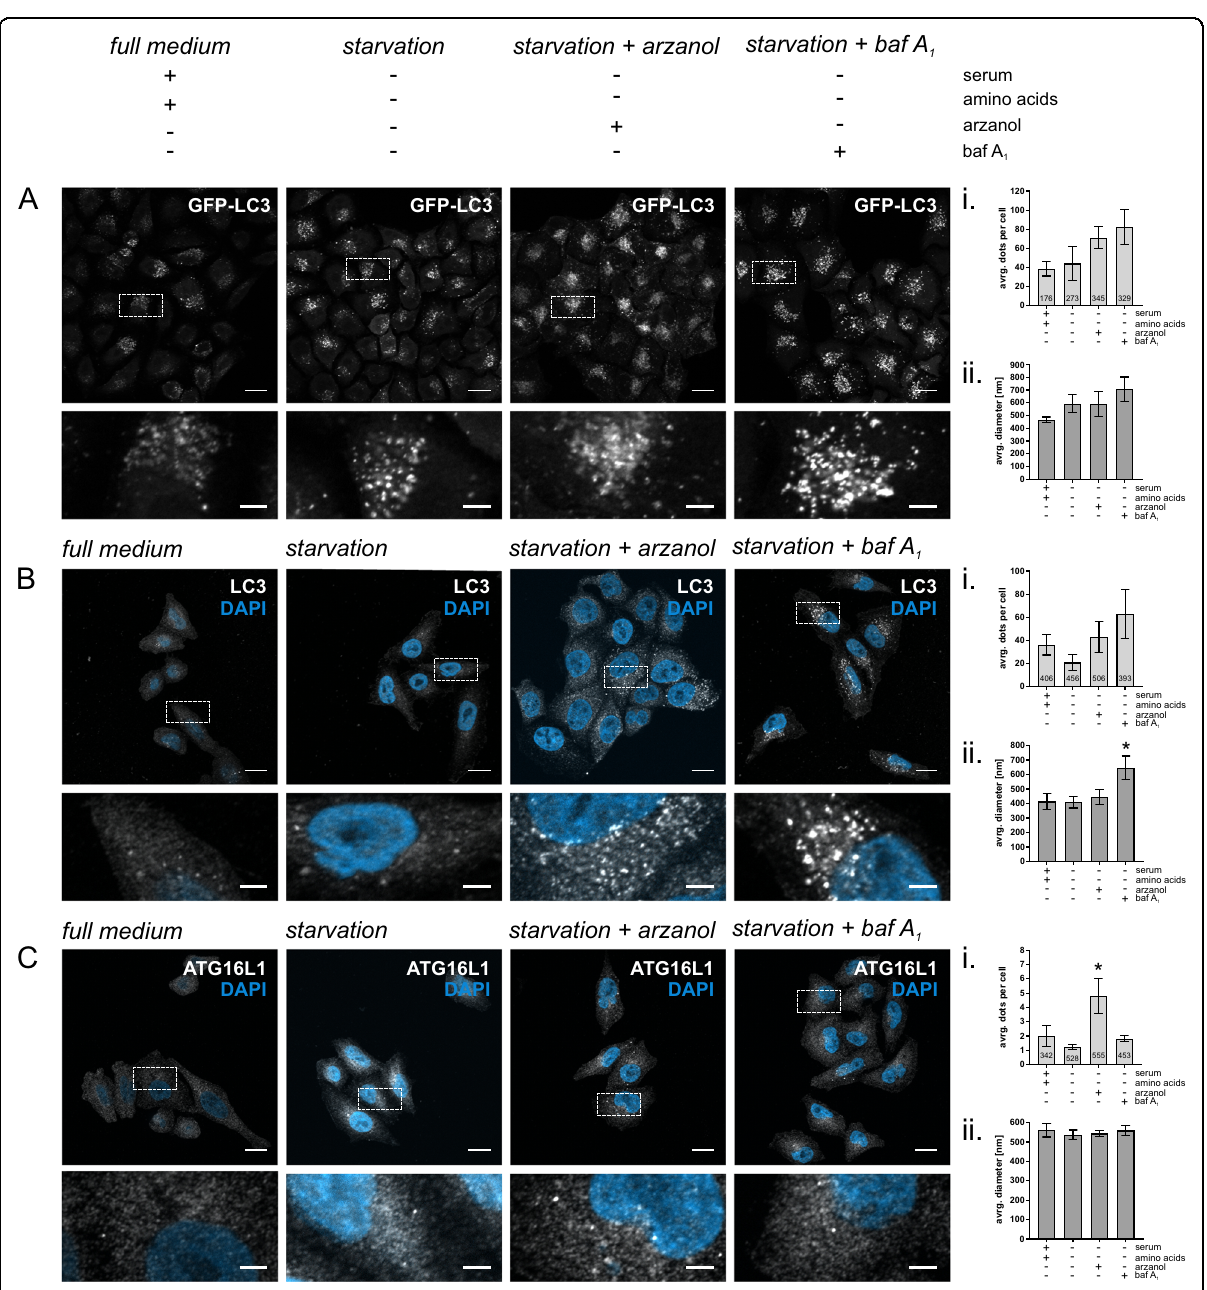
Fig. 3 Arzanol interferes with autophagosome elongation. Shown are representative microscopy images of HeLa cells stably expressing GFP- LC3-RFP-LC3 Δ G ( A ), or wild-type HeLa cells immuno fl uorescently labeled for endogenous LC3 ( B ) or ATG16L1 ( C ). All cells were starved in serum- and amino acid-free medium for 2 h while incubated with 3 µM arzanol or 10 nM ba fi lomycin A 1 . Scale bars in upper panels are 15.5 µm, scale bars in magni fi cations are 3.875 µm. (i) Data show the average number of dots per cell from biological triplicates for GFP-LC3, and n = 6 for LC3 and ATG16L1 as mean ± SEM. Digits in bars show the total number of cells quanti fi ed using ImageJ software. (ii) Data show the average diameter of dots in nm as mean ± SEM. Statistical analysis was performed using ordinary one-way ANOVA with Tukey ’ s multiple comparison test, * P <